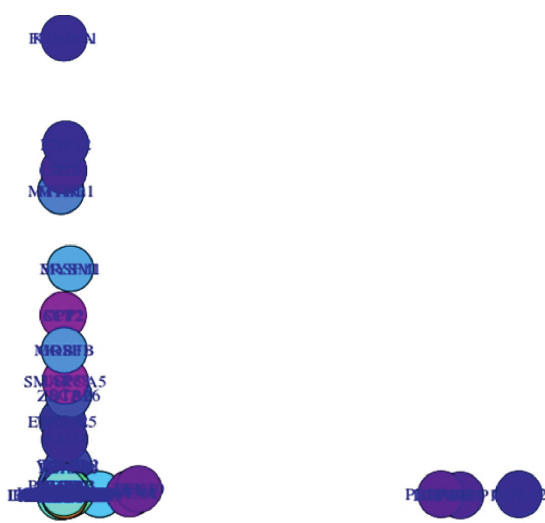
Figure 6: Complex network diagram of TOM gene at threshold λ � 0 .